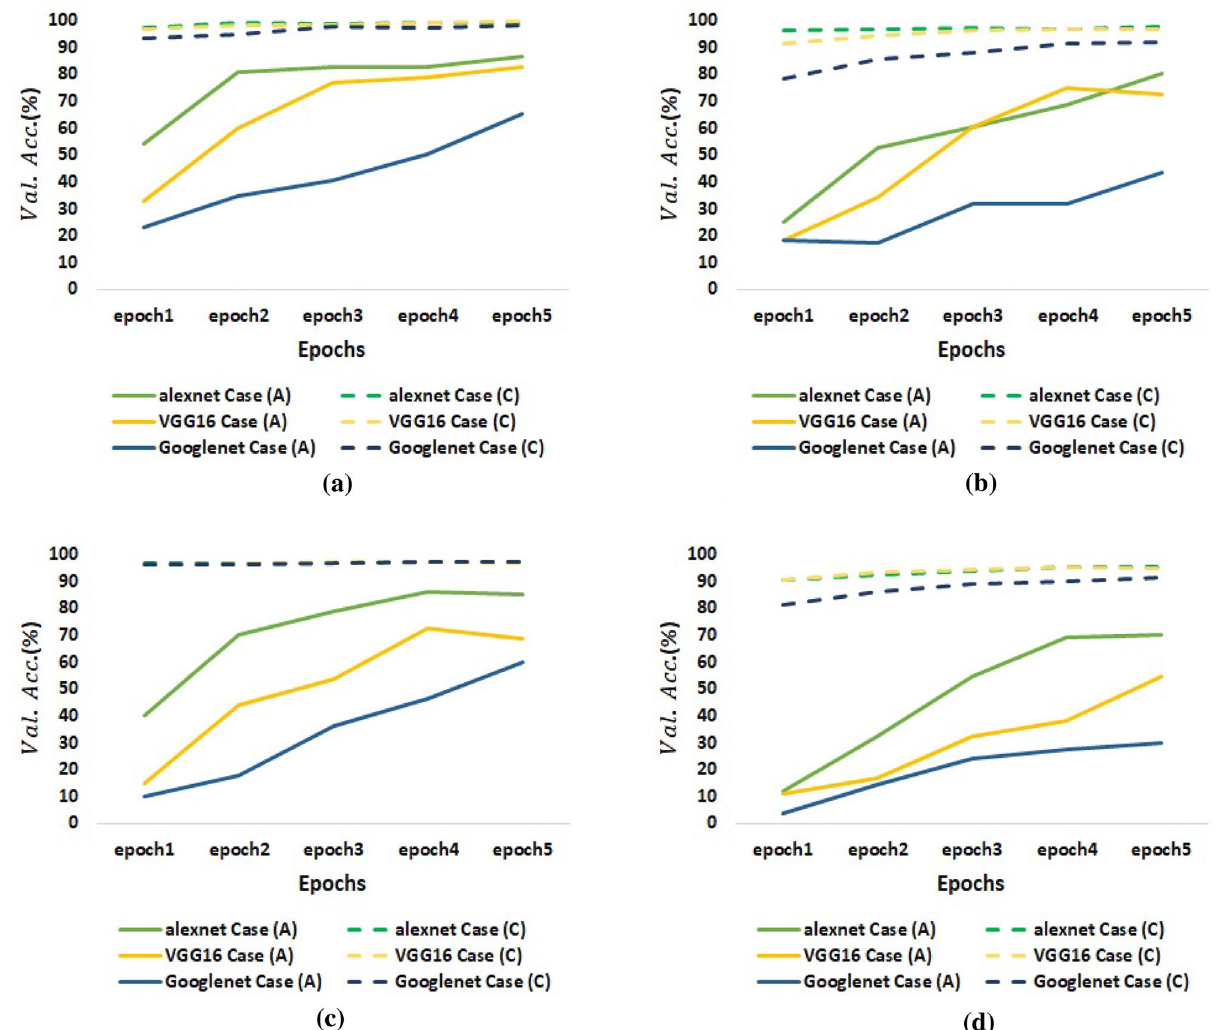
Figure 12. Visualization for Val . Acc . achieved at each epoch in Case ( A ) and Case ( C ) for ( a ) Latin dataset, ( b ) Malay dataset, ( c ) Korean dataset, and ( d ) Sanskrit(Indo-Aryan)